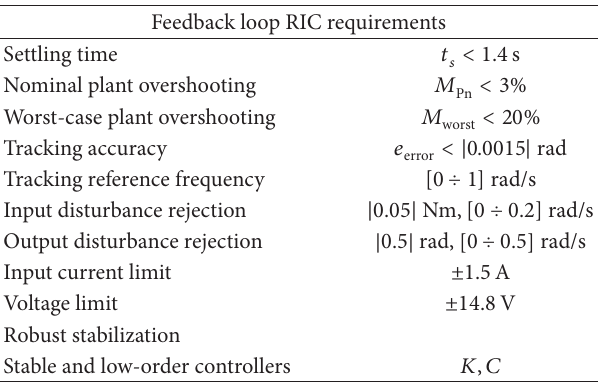
Table 3: RIC control requirements.